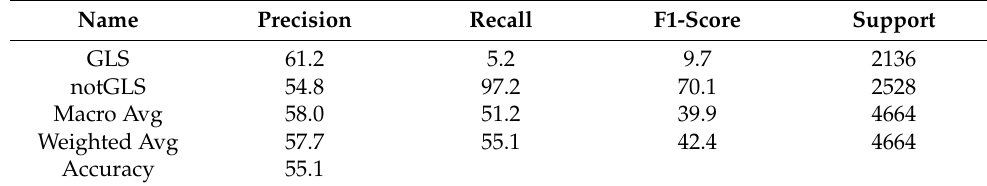
Table 8. Performance of GLS_net_pv upon the IF testing set.